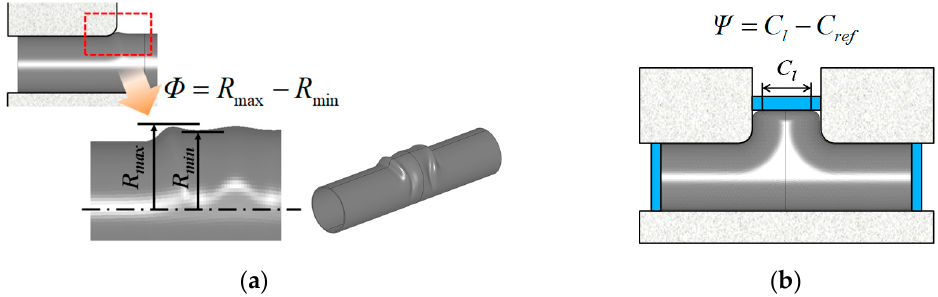
Figure 11. Evaluation functions for T-shape forming. ( a ) Evaluation function Φ for the risk of wavy buckling; ( b ) Evaluation function Ψ for the contact length with counter punch . R max : maximum bulged height (radius) near the die inlet shoulder part; R min : minimum bulged height (radius) near there; C l : contact length with a counter punch; C ref : assumed reference contact length. A red rectangle indicates a maximum bulged part region near the die inlet.